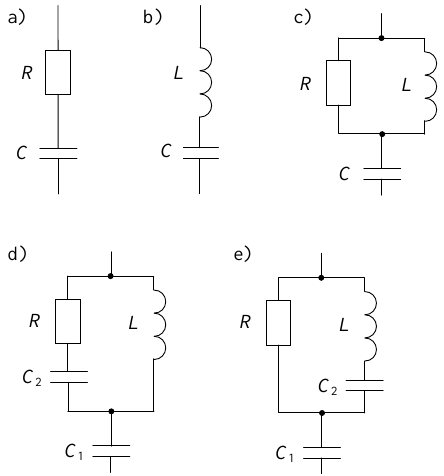
Figure 1. Types of filters used in the HV networks according to EN 61642 [36]. ( a ) First-order filter. ( b ) Second-order filter—undamped filter. ( c ) Second-order filter—damped filter with a resistor. ( d ) Third-order filter—damped filter. ( e ) Third-order filter—C-type filter.